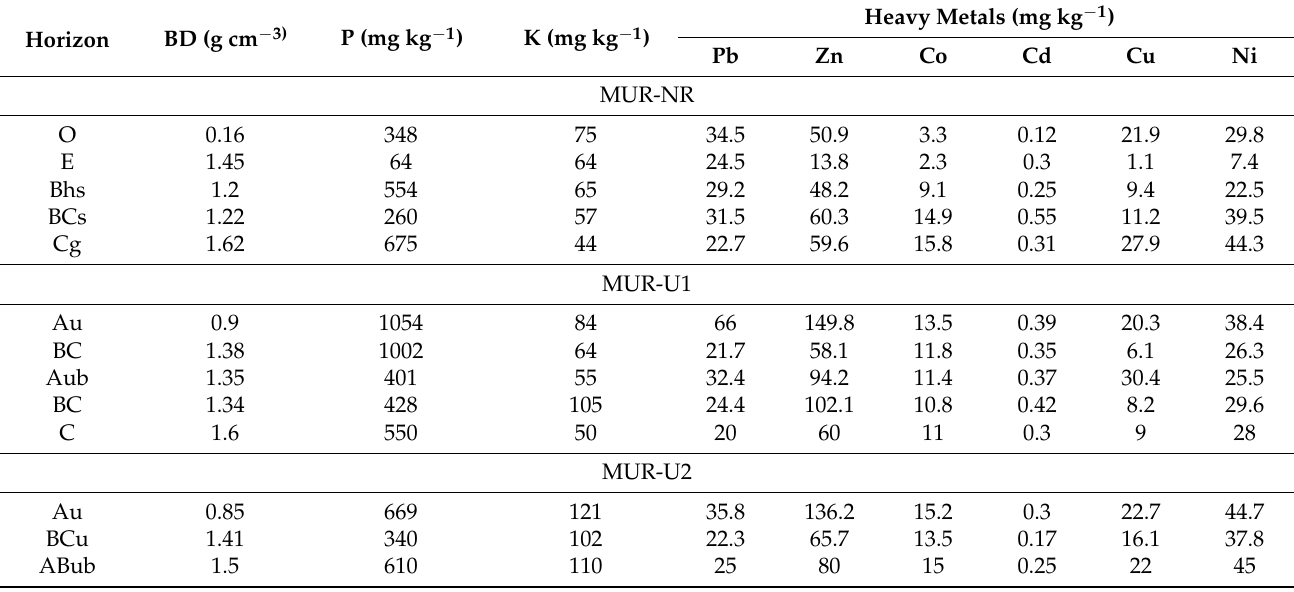
Table 2. Chemical and physical properties of urban and natural soils in Murmansk area.